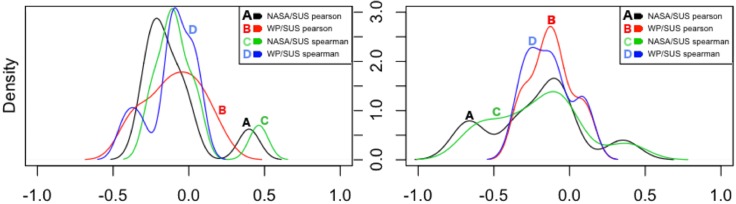
Density plots of the correlations by task—Group A, B.